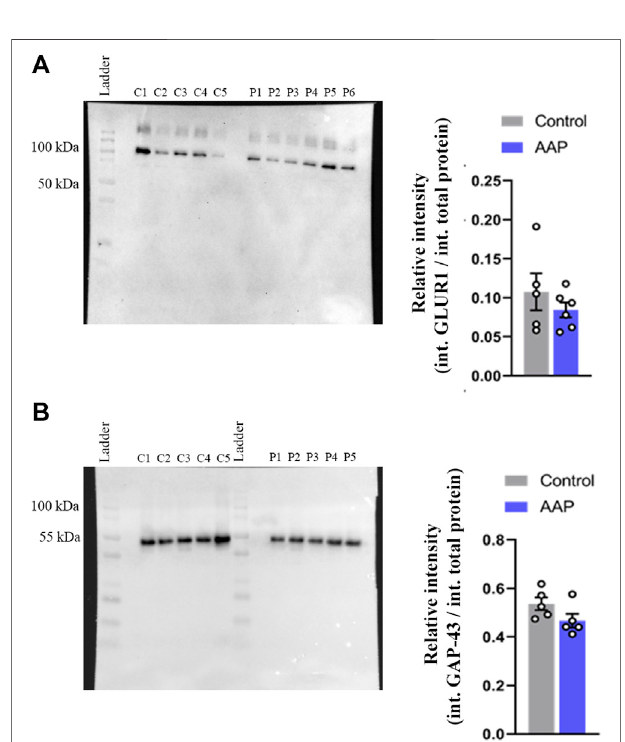
FIGURE 3 | Protein levels, presented as relative intensity of total protien levels, of (A) GLUR1 and (B) GAP-43 of male NMRI mice 24 h after exposure to either vehicle (control) or 30 + 30 mg/kg AAP. “ C1-5 ” represent control samples in the blot; “ P1-6 ” represents AAP samples in the blot. The height of the bars represent the mean ± SEM value of fi ve to six animals.